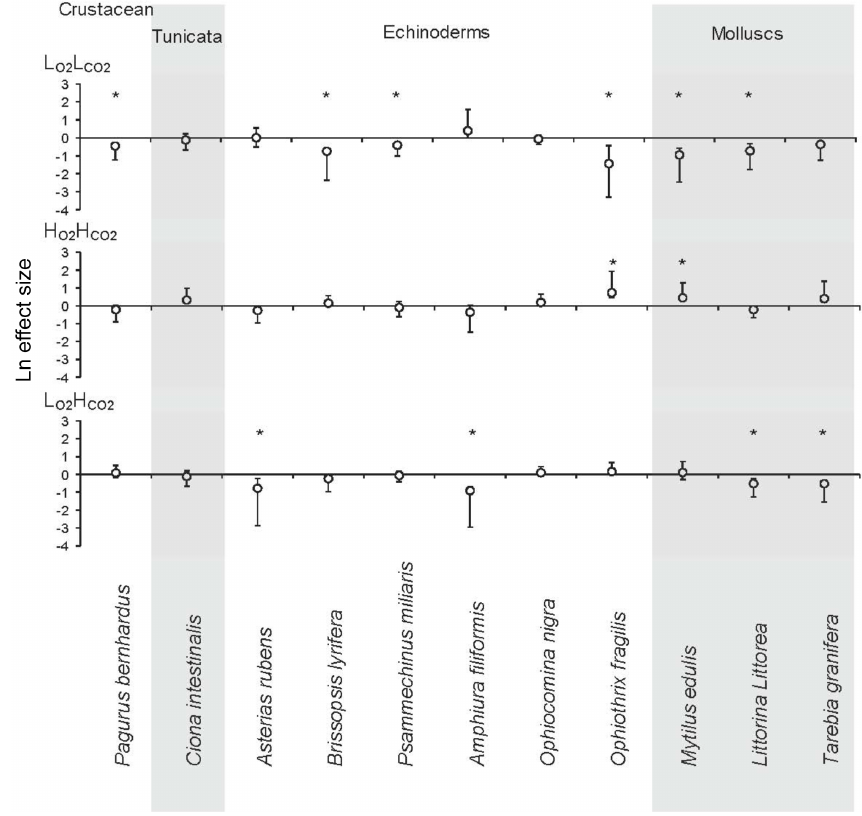
Figure 2. The Ln effect size of the response ratios for invertebrate species and phyla in response to three treatments: low O 2 (L O low pH (H O H CO ) and coupled low O 2 and low pH (L O 2 2 ln(control) ± Bias-corrected bootstrapped 95% confidence interval (after Gurevitch and Hedges, 1999; Hedges et al., 1999; Kroeker et al., 2010). The zero line indicates no effect, and significance of mean effects is determined when the 95% confidence interval does not overlap zero (significant results marked with “*”). Grey background was added to summarize the species by phyla. physiological limits to low O 2 concentrations seem